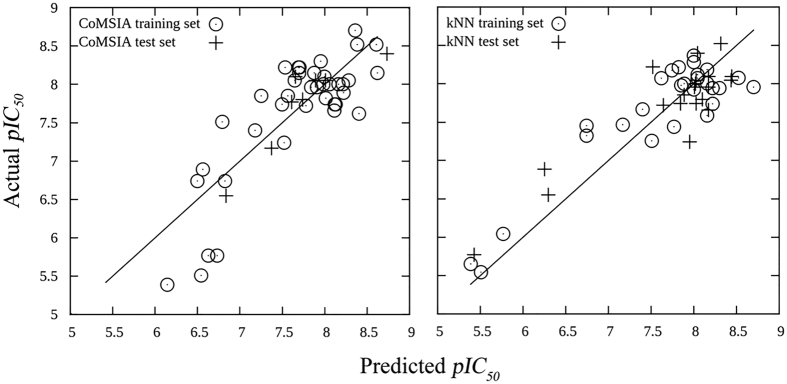
Predicted pIC50 values versus actual pIC50 values for CoMSIA model (left) and kNN model (right).The predicted pIC50 for both training sets are predicted by leave-one-out cross-validation.